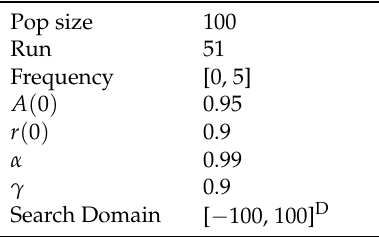
Table 3. The CEC2013 benchmark set.